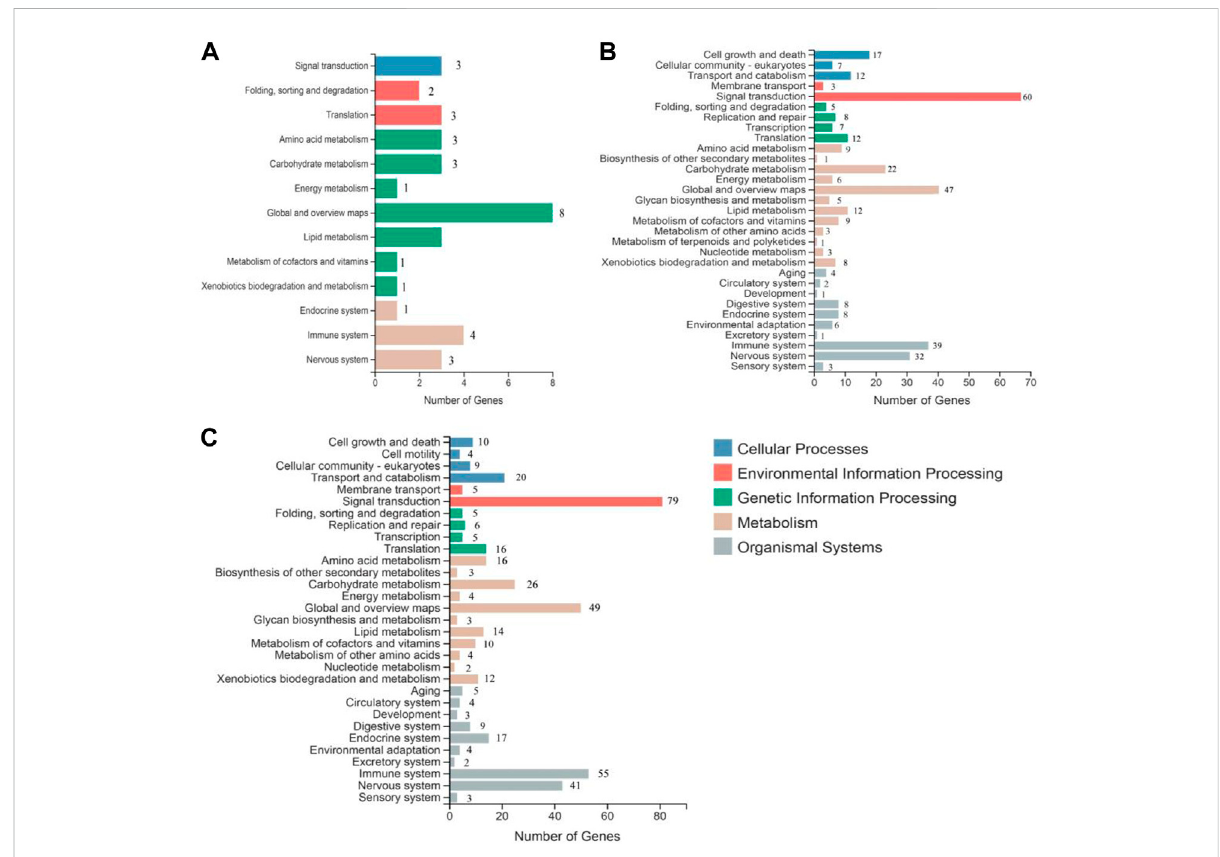
Box and TATA-box as follows: 1) light-responsive elements